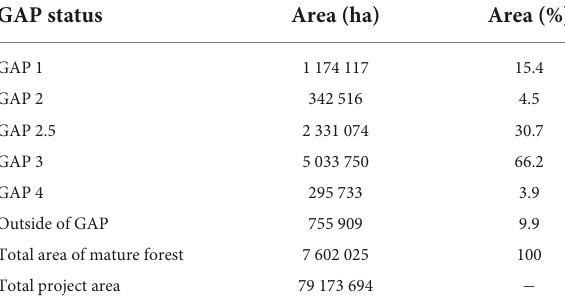
TABLE 2 Mature and old-growth forests area (%) within the proposed five state protection area (OR, WA, ID, MT, and WY) that includes Northern Rockies Ecosystem Protection Act by GAP